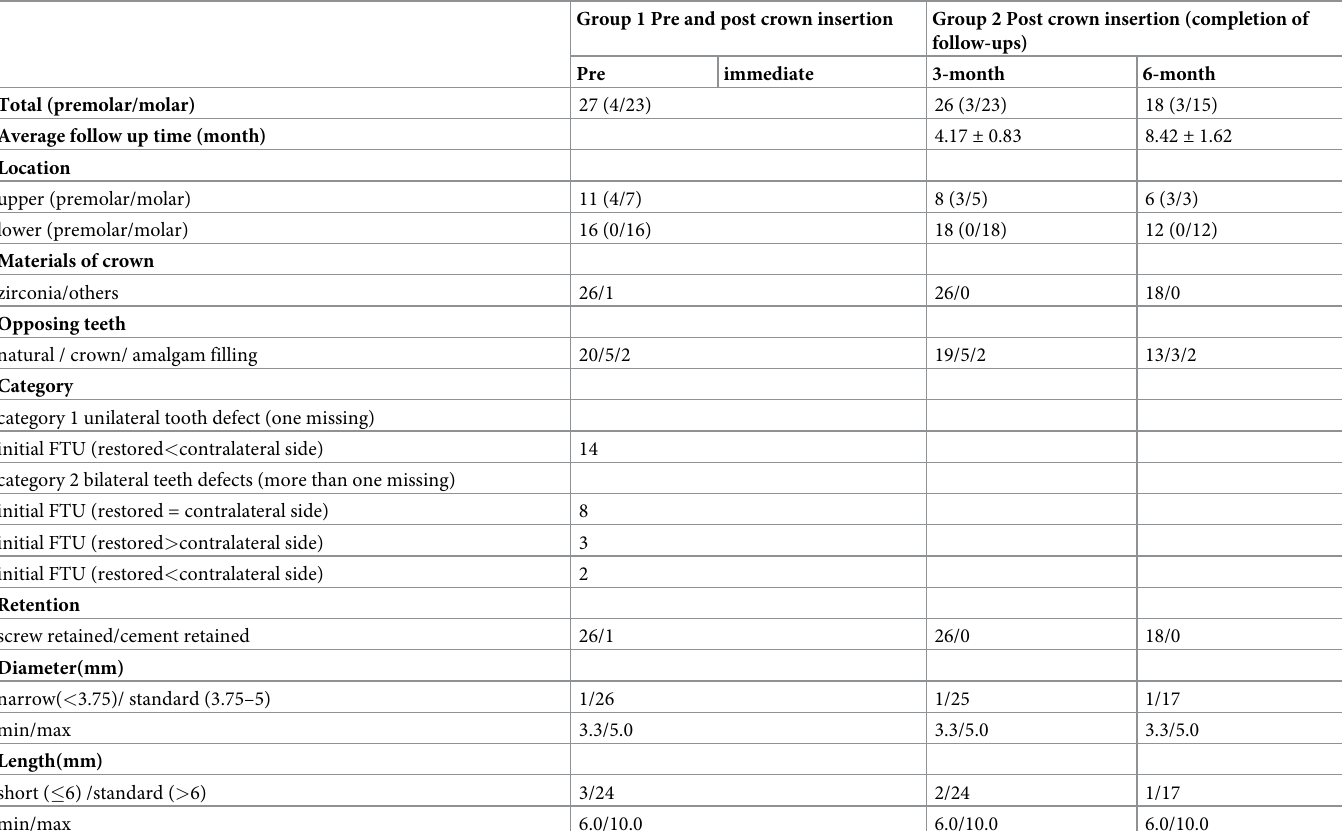
Table 2. Details of the implants and prostheses.